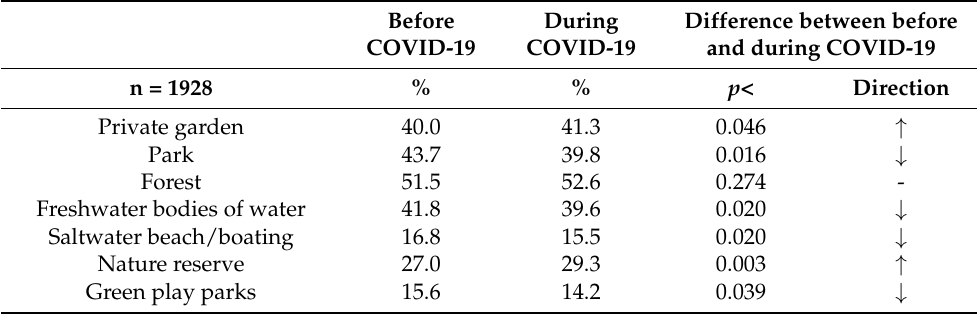
The average weekly consumption of alcohol was significantly higher during the pandemic than before the pandemic in the total sample as well as in several subgroups (see Table 5). The percentage of individuals with daily alcohol intakes above the low risk level were significantly higher during the pandemic than before the pandemic in almost all the subgroups (Table